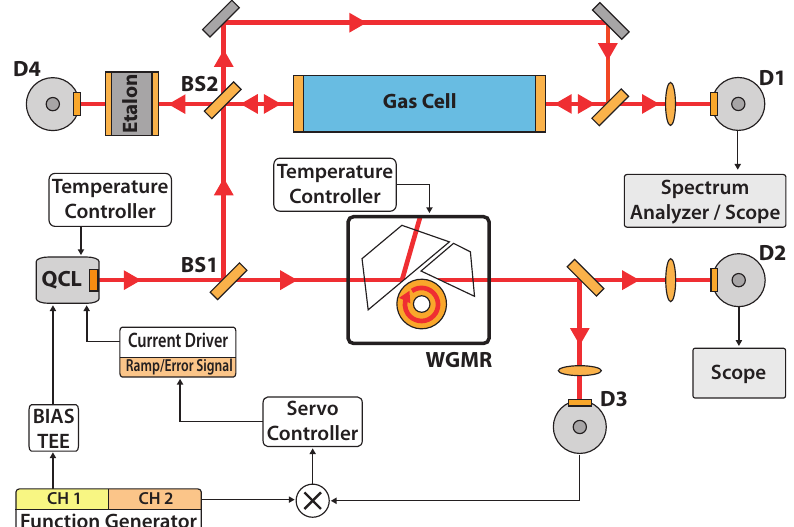
Figure 1. Schematic of the experimental setup used for electronic frequency stabilization. BS1, BS2: beam splitters. D1 and D2: InSb photodiodes; D3: HgCdTe photodiode; D4: PbSe